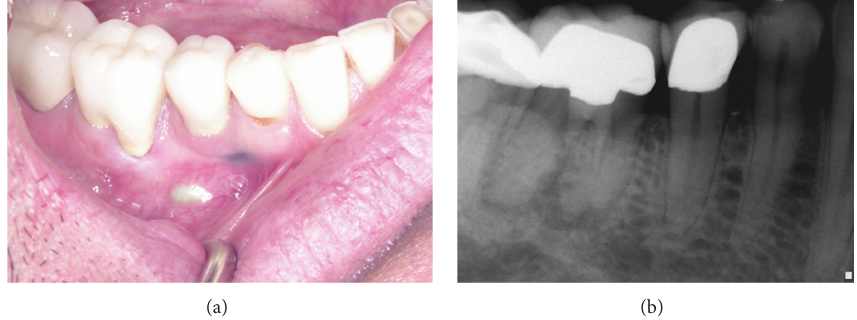
Figure 1: (a) 5mm by 3mm yellowish-white mass in the mucobuccal fold region of the lower right second premolar. A bluish-purple hyperpigmentationsimilartotheappearanceofanamalgamtattooisalsonotedonthealveolarprocessbetweenthepremolars.(b)Radiograph shows no radiopacity in the region of the premolars. The lingual tori can be seen as well-defined areas of radiopacity overlying the tooth roots of the molars.